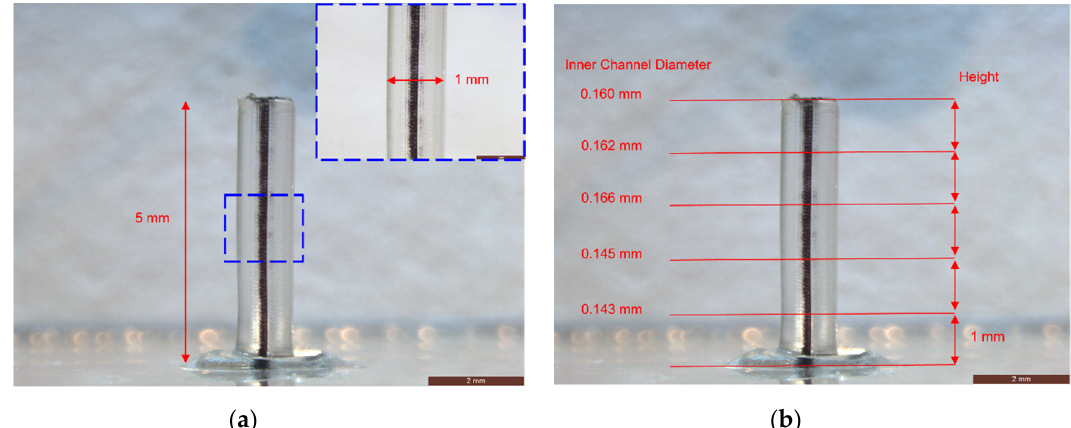
Figure 4. Dimensional characterization of 3D-printed connectors under the microscope: ( a ) the measurement of outer diameter and height; ( b ) the measurement of inner channel dimension.